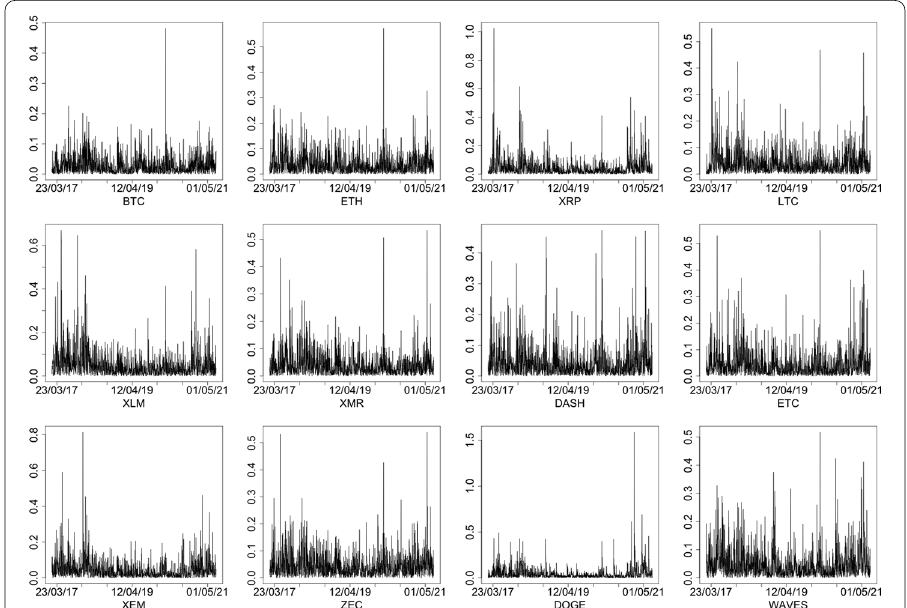
Fig. 2 Dynamics of | r t − µ | , where r t are the 12 CCs’ log return considered and µ is the corresponding mean